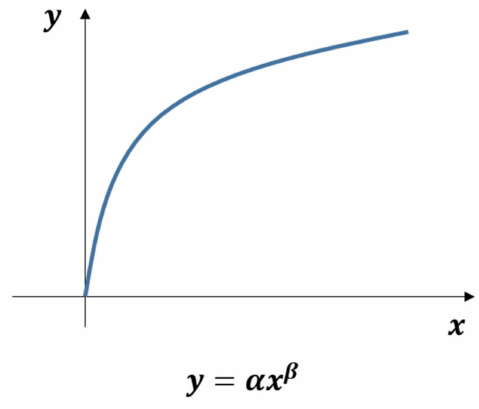
Figure 3. Logarithmic regression analysis